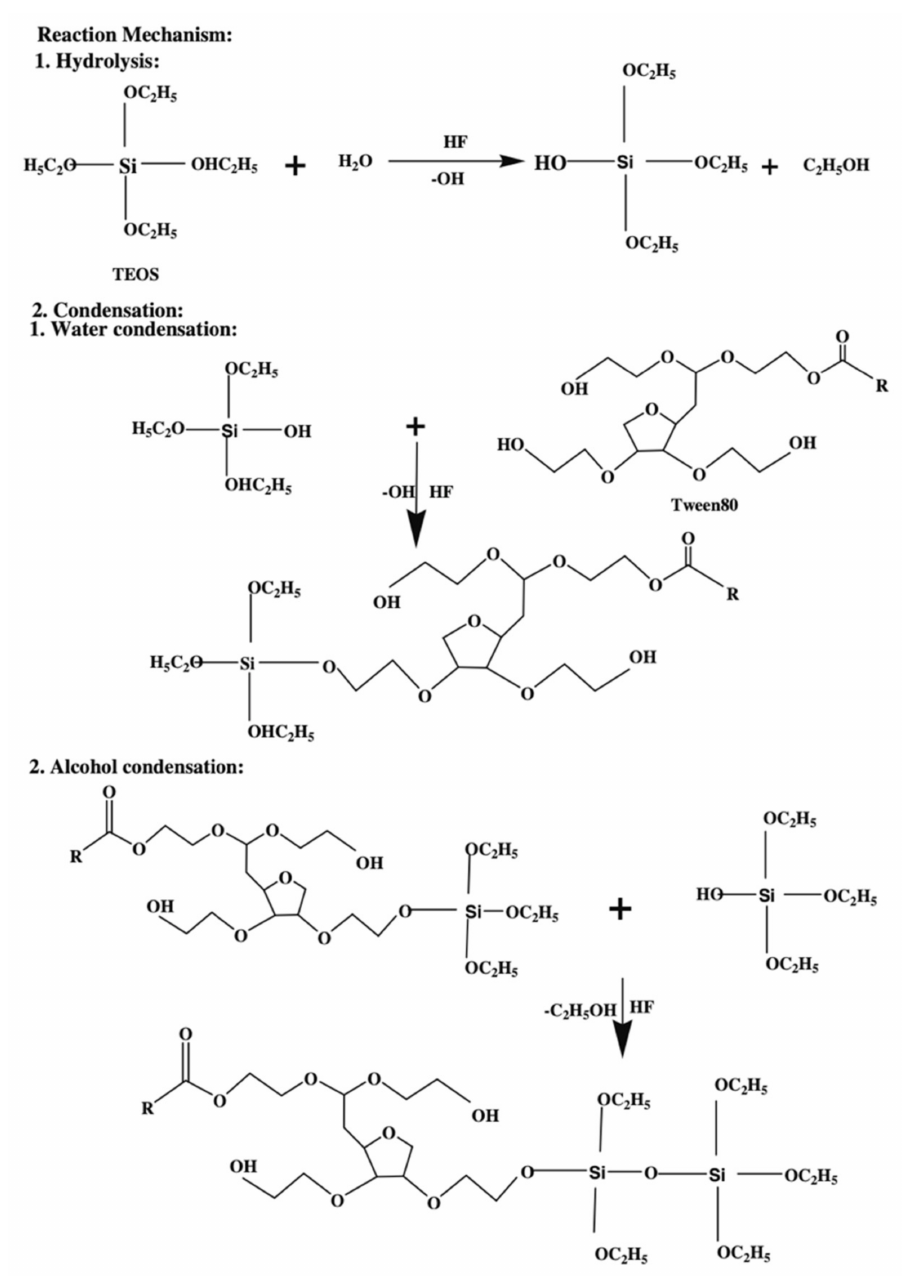
Figure 8. Synthetic route for porous TEOS “wet gel”